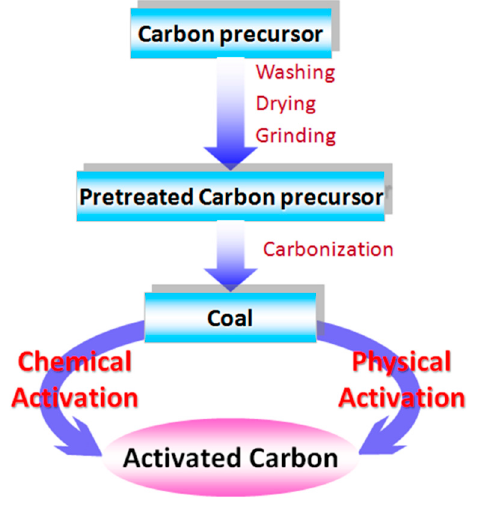
Figure 3. Steps for preparation of activated carbons.